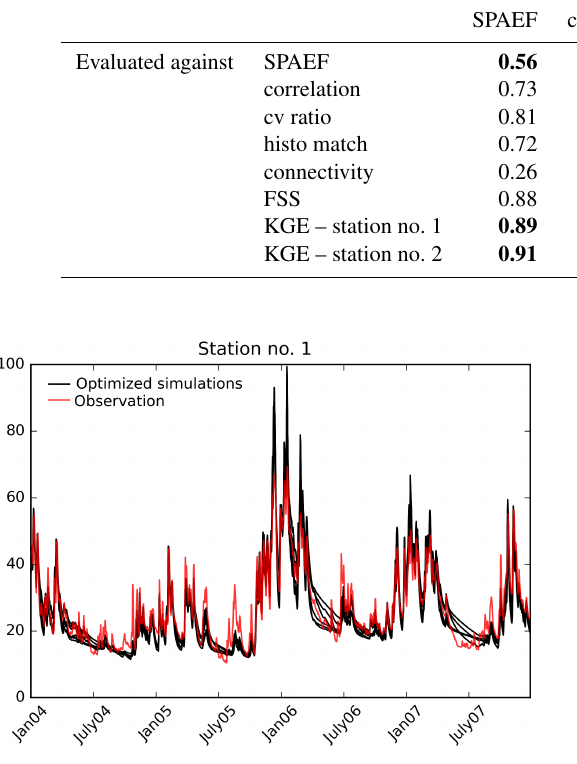
Figure 5. Simulated discharge at station no. 1 obtained by the six optimizations. Data are shown only for 4 out of the 8 years of sim- ulation. KGE values vary between 0.84 and